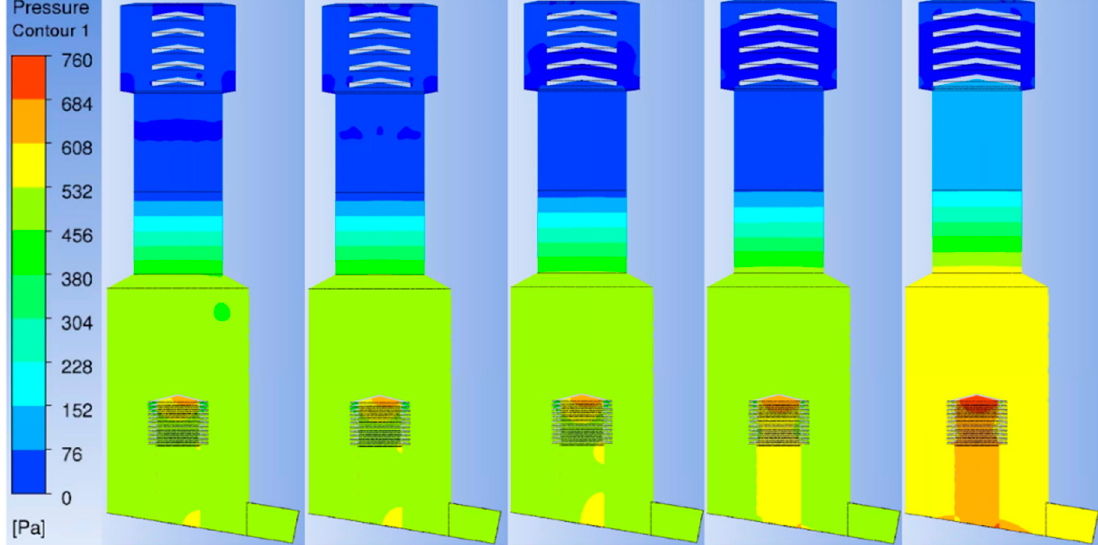
Figure 14. Pressure contour according to the vane length in the inner vane reverse type.